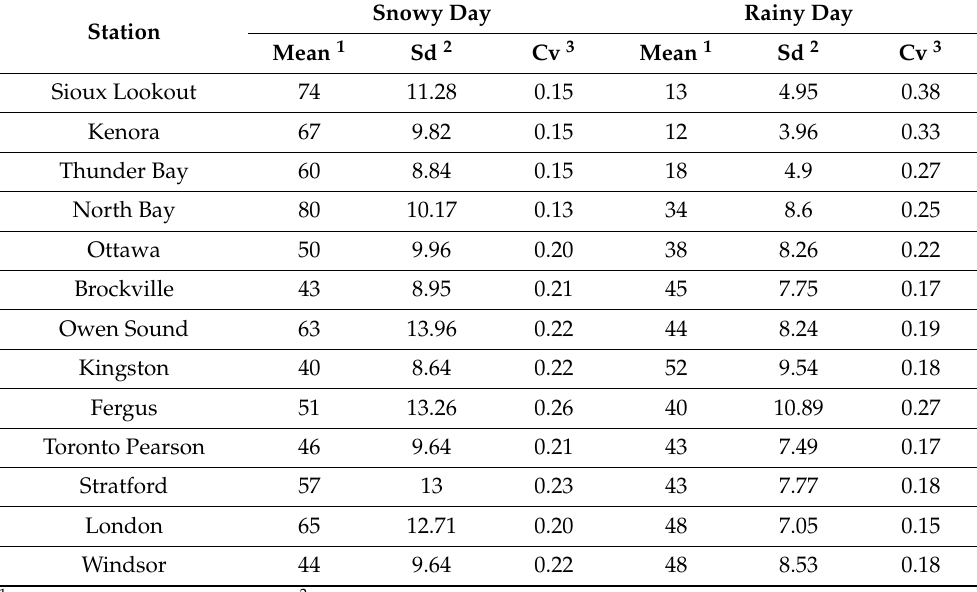
Table 6. Central tendency and variability statistics relating to number of snowy days and rainy days for selected stations across Ontario. Snowy Day Station